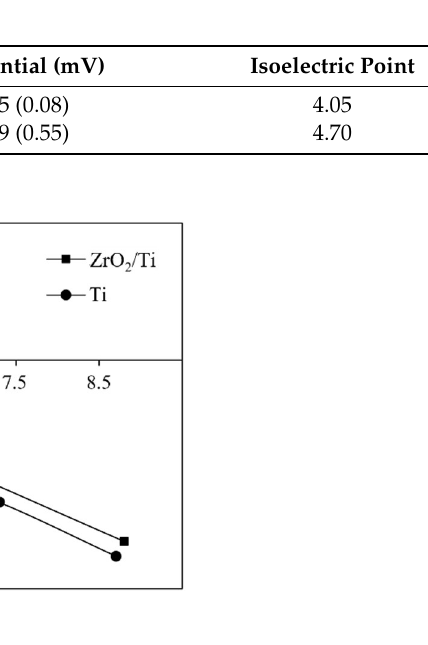
Figure 9. pH-dependent curves of the apparent zeta potentials of Ti and ZrO 2 /Ti at any pH level. Table 2. Apparent zeta potentials at a pH level of 5.6, and the isoelectric points of the Ti and ZrO 2 /Ti specimens.